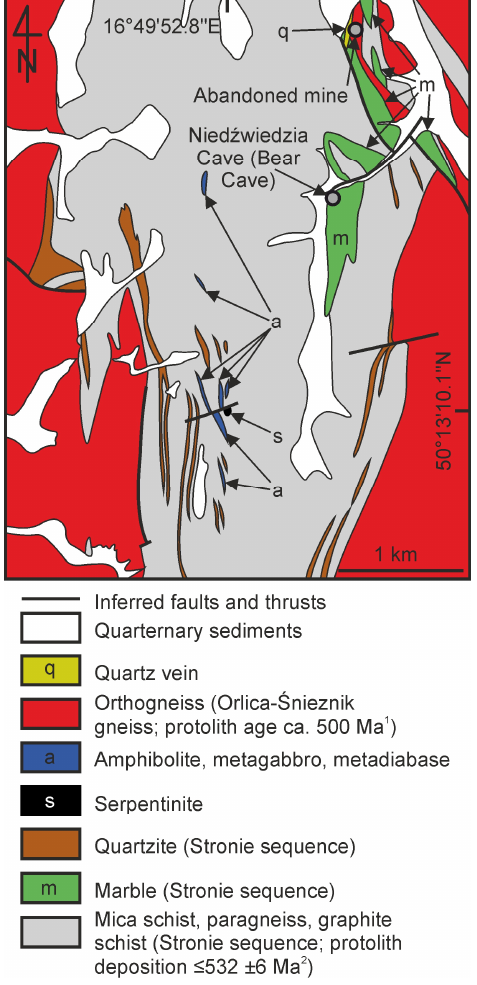
Figure 2. Schematic geological map of the Kletno deposit and ˙ Zmijowiec Rib (modified after Fr ˛ackiewicz and Teisseyre